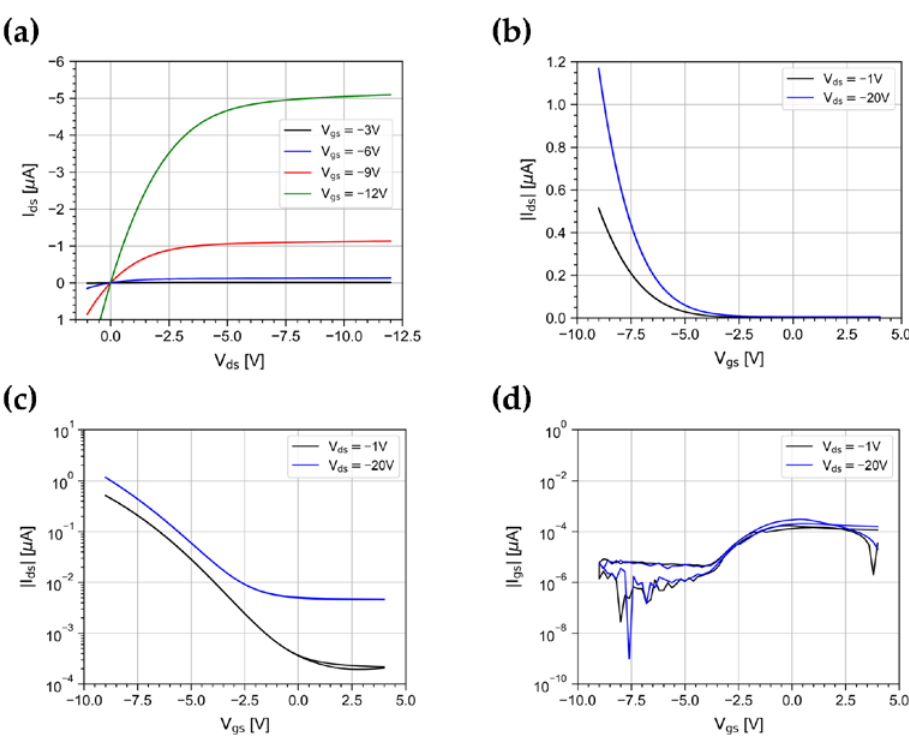
Figure 2. ( a ) Output characteristics for V gs varying between − 3 V and − 12 V in steps of 3 V, and transfer characteristics in linear (V ds = − 1 V) and saturation regimes (V ds = − 20 V) represented in ( b ) linear and ( c ) log-y scale. ( d ) Gate leakage current curves for V ds = − 1 V and V ds = − 20 V.